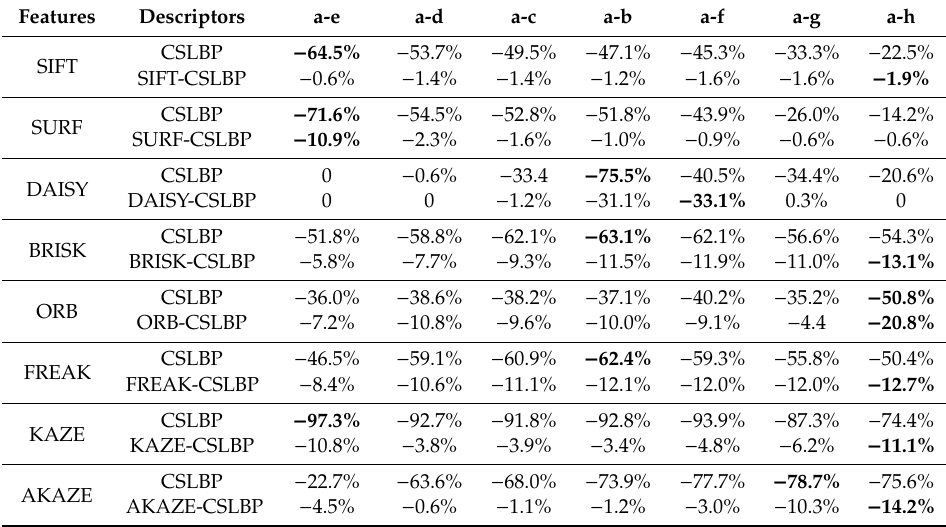
Figure 18. Matching results of the precision of Ubc sequence for the eight original, the CSLBP, and the combined descriptors. The X label represents the matched images of Ubc sequence, and the Y label denotes the precision for each descriptor. ( a ) SIFT features; ( b ) SURF features; ( c ) DAISY features; ( d ) BRISK features; ( e ) ORB features; ( f ) FREAK features; ( g ) KAZE features; ( h ) AKAZE features. Table 9. The reduced values of recall for the CSLBP and the combined descriptors compared to the original descriptors of Ubc sequence.